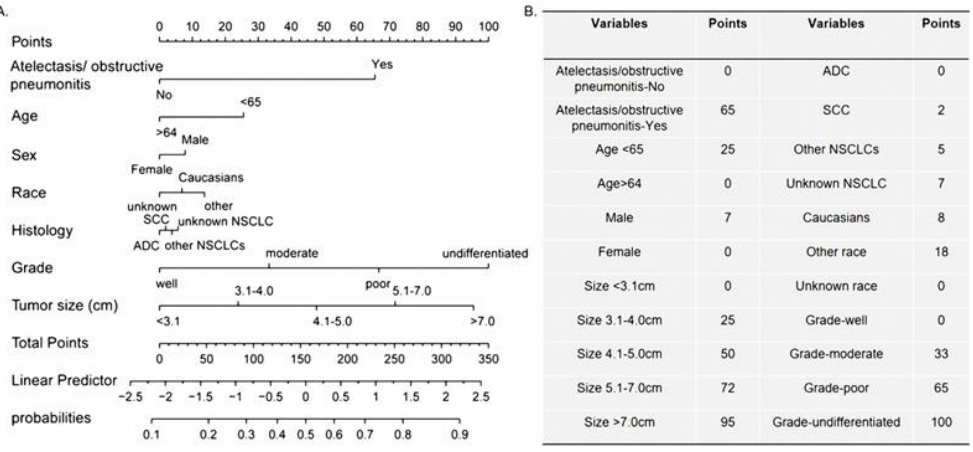
Figure 2. Nomogram predicting lymph node metastasis (N1/N2 stage) for non-small cell lung cancer. ( A ). Scoring rubric of the nomogram ( B ).